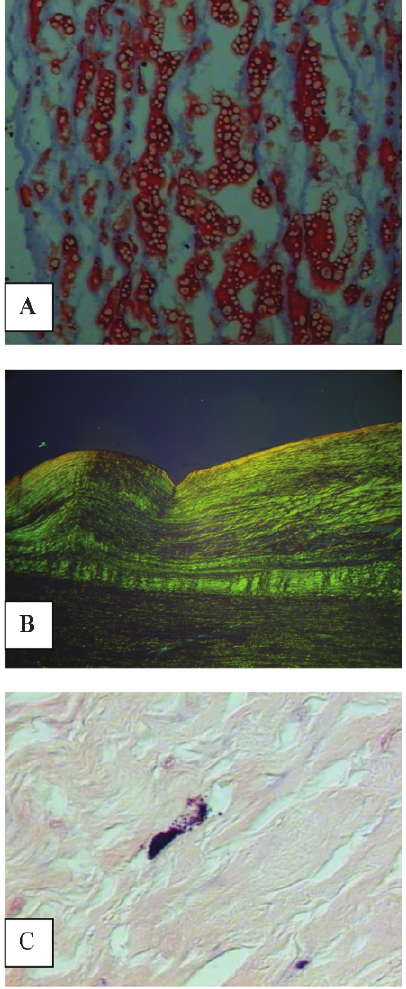
Figure 1 - (A) Lipid deposition in the tunica intima of the aorta of autopsied patients, identified by red staining (Sudan Red, 800X). (B) Collagen birefringence in the tunica intima of the aorta can be observed under polarized light (Picrosirius, 200X). (C) Purple- stained mast cell in the layers of the aorta